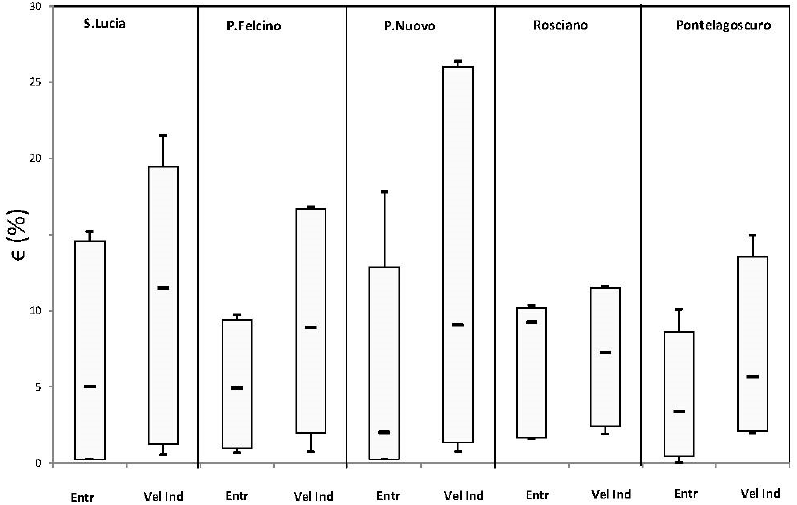
Figure 6. Box ‐ plot of the absolute percentage error ( (cid:2035) ) in estimating the cross ‐ sectional mean flow Figure 6. Box-plot of the absolute percentage error ( (cid:101) ) in estimating the cross-sectional mean flow velocity using the Entropy approach (Entr) and the velocity index (Vel Ind). velocity using the Entropy approach (Entr) and the velocity index (Vel